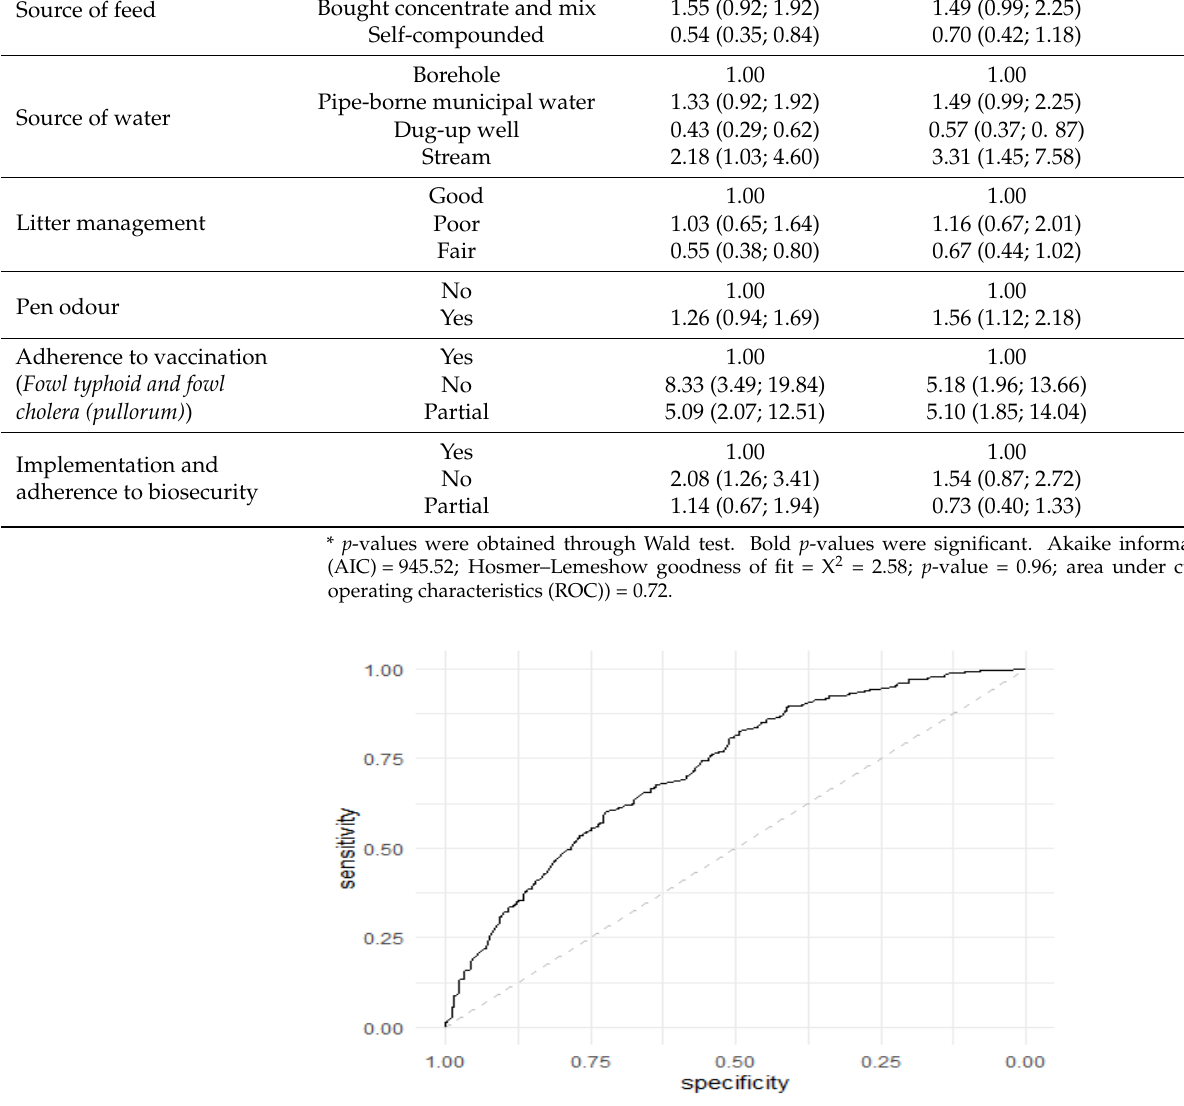
Figure 2. Receiver operating characteristics of risk factor model for persistent infection of non-typhoidal Salmonella on poultry farms, North Central Nigeria. The ROC curve (solid curve) per- formed better than the diagonal line (dotted line) at 0.72, a reflection that the performance of the diagnostic test that is better than chance level.